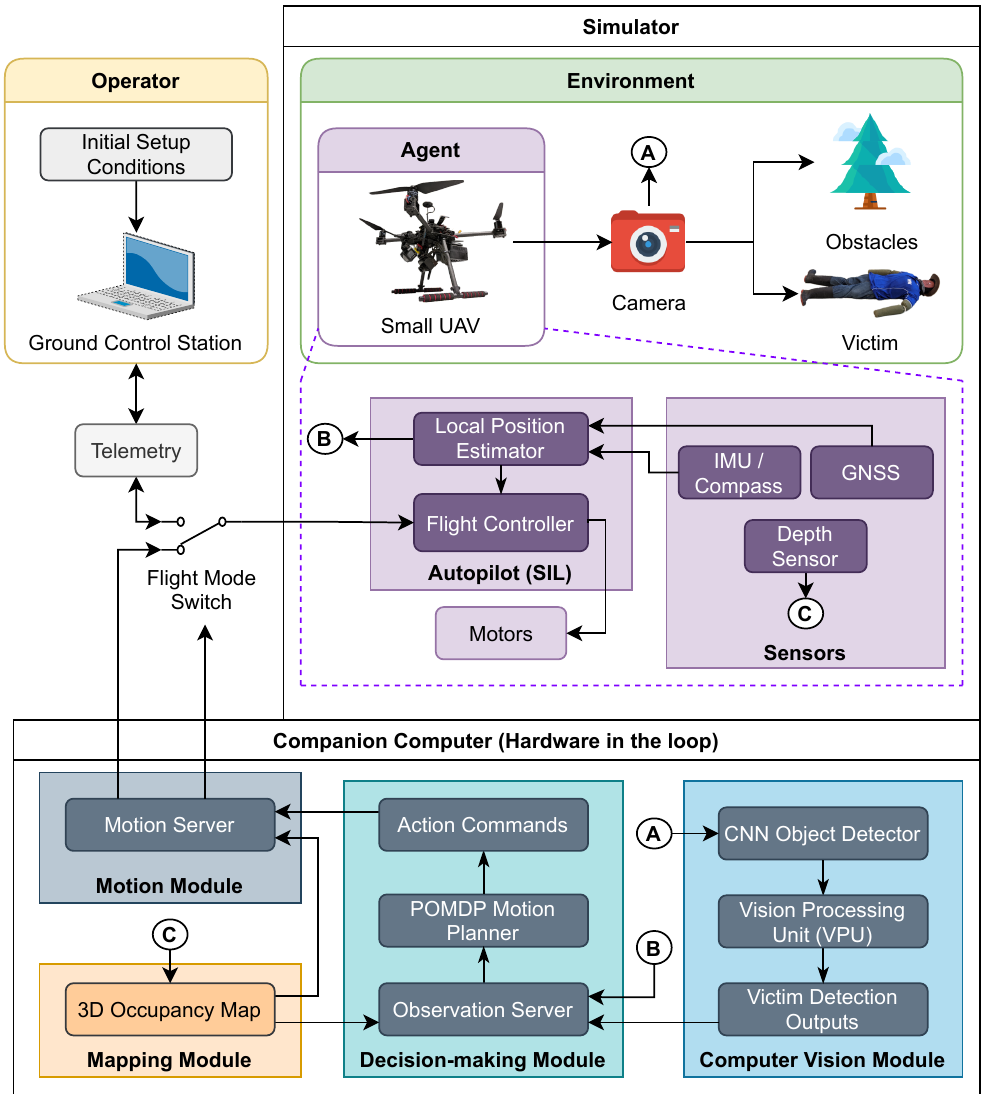
Figure 2. System architecture for applications with rich global navigation satellite system (GNSS) coverage. The environment, UAV, payloads, victim, and obstacles are emulated in a simulator. The computer vision, decision-making, mapping, and motion modules run in hardware in the loop (HIL) using a companion